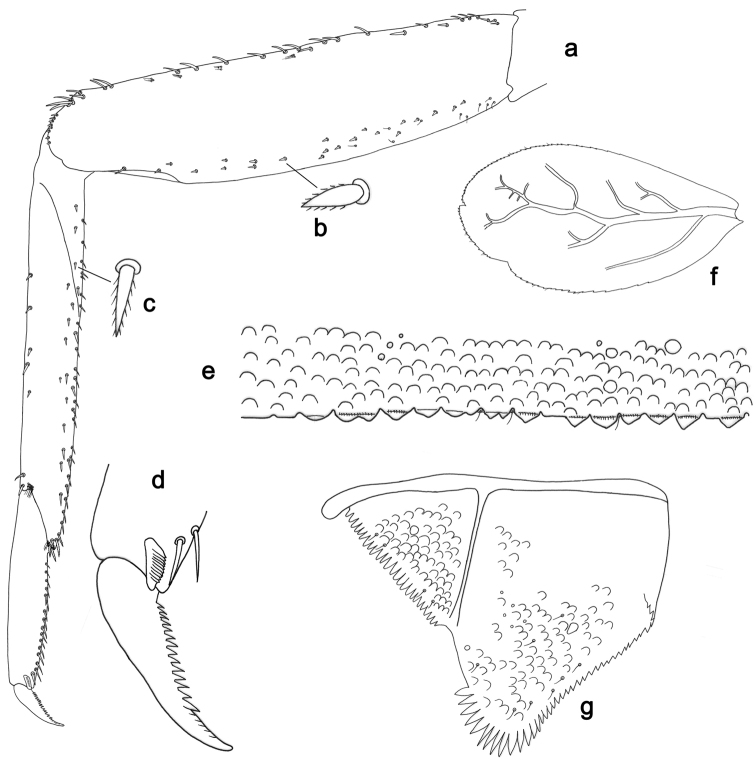
Labiobaetisorientis sp. n., larva morphology: a Hind leg b Femur ventral seta c Tibia ventral seta d Hind claw eTergum IV f Gill V gParaproct.